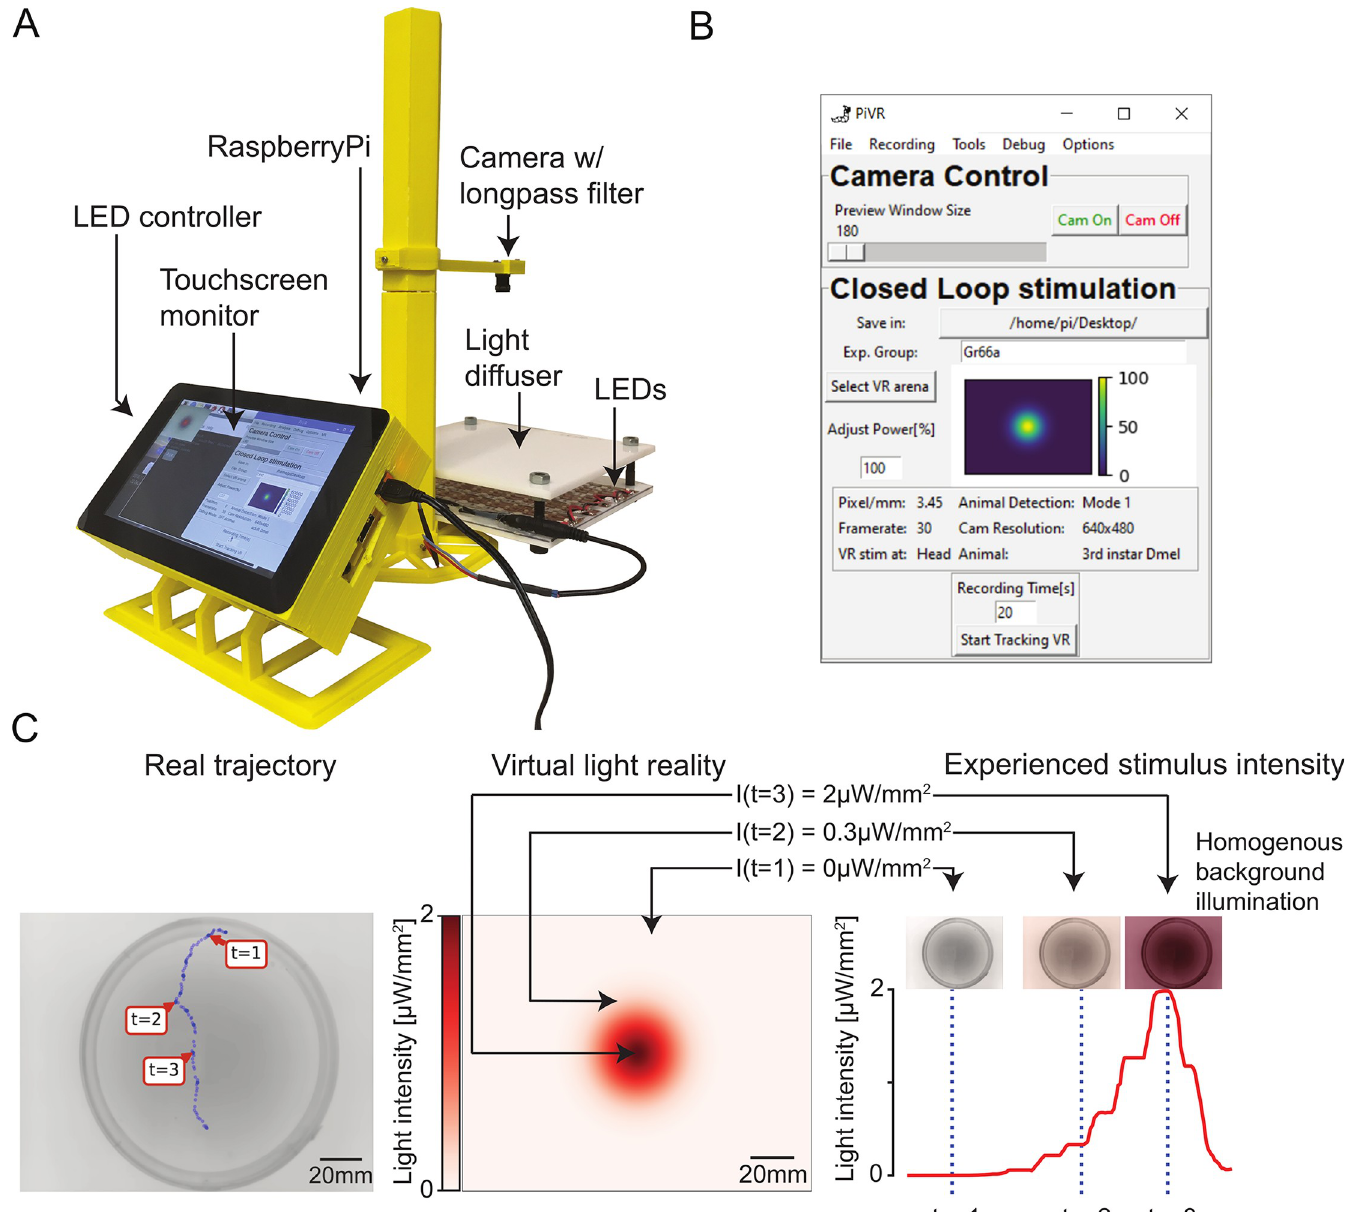
Fig 1. Virtual realities created by PiVR. (A) Picture of the standard PiVR setup. The animal is placed on the light diffuser and illuminated from below using infrared LEDs and recorded from above. The Raspberry Pi computer and the LED controller are attached to the touch screen, which permits the user to interface with the PiVR setup. (B) Screenshot of the GUI while running a virtual reality experiment. The GUI has been designed to be intuitive and easy to use while presenting all important experimental parameters that can be modified. (C) Virtual realities are created by updating the intensity of a homogeneous light background based on the current position of a tracked animal mapped onto a predefined landscape shown at the center. (Center) Predefined virtual gradient with a Gaussian geometry. (Left) Trajectory of an unconstrained animal moving in the physical arena. (Right) The graph indicates the time course of the light intensity experienced by the animal during the trajectory displayed in the left panel. Depending on the position of the animal in the virtual-light gradient, the LEDs are turned off (t = 1) or turned on at an intermediate (t = 2) or maximum intensity (t = 3). GUI, graphical user interface; LED, light-emitting diode; PiVR, Raspberry Pi Virtual Reality.